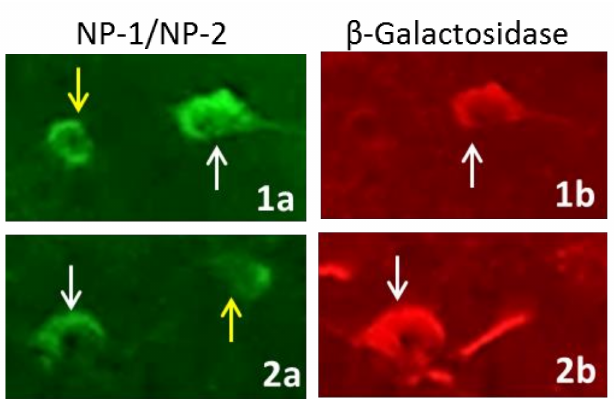
Figure A1. Immunohistochemistry for guidance cue receptors in CRMP3 − / − mice. Co-localization of NP-1 ( 1a ) and NP-2 ( 2a ) with β -galactosidase ( 1b , 2b ) in CRMP3 − / − DG. White arrows point at cells positive both for NP-1 + and β -galactosidase + ( 1a and 1b ) or both NP-2 + and β -galactosidase + ( 2a and 2b ). Yellow arrows point to cells positive for NP-1 + ( 1a ) or NP-2 + ( 2a ) and negative for β -galactosidase − . Scale bar: 10 µ m in